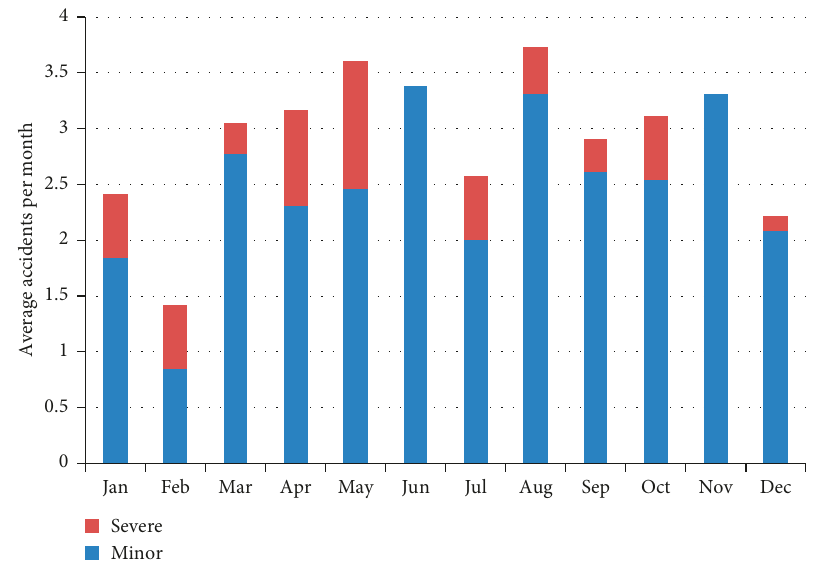
Figure 3: Average roof fall accidents per month for Mchenga Coal Mine (1995 to 2009).